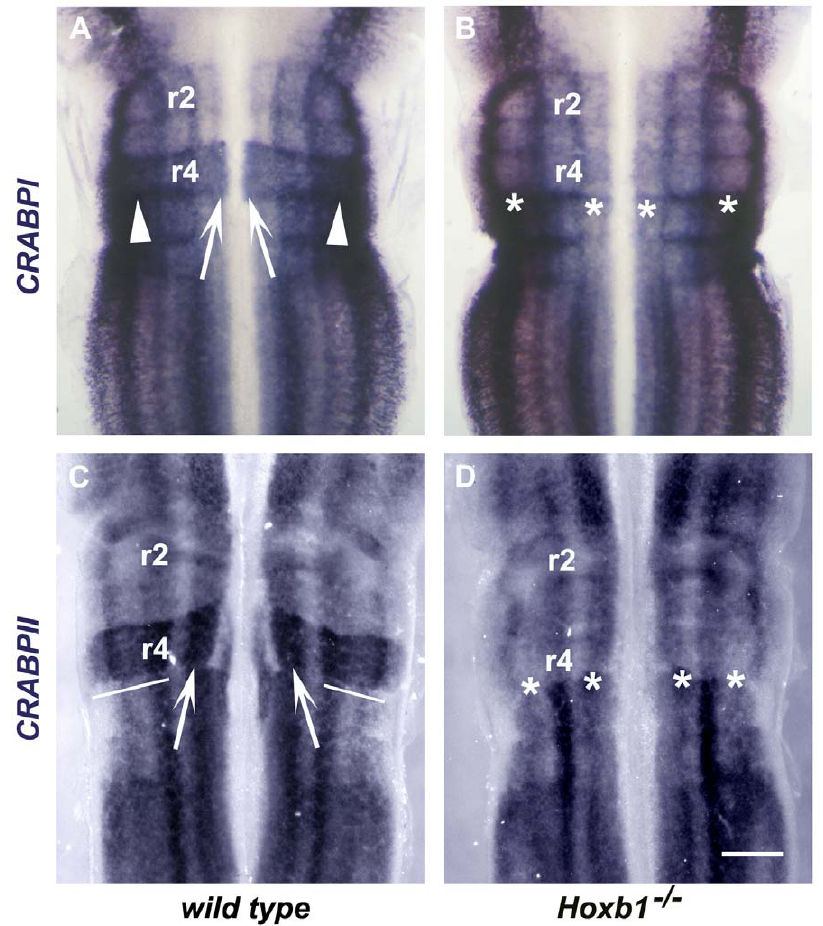
Figure 3. Expression of CRABPI and CRABPII in the hindbrain of wt and Hoxb1 2 / 2 mouse embryos at 10.5 dpc. (A – D) Ventricular views of flat mounted wt (A, C) and Hoxb1 2 / 2 (B, D) mouse hindbrains stained with a CRABPI riboprobe (A, B) and a CRABPII riboprobe (C, D) at 10.5 dpc. r4-specific expression is denoted by arrows (A, C), arrowheads (A) and brackets (C) in wt hindbrains. r4-specific expression is lost in Hoxb1 2 / 2 hindbrains and denoted by asterisks (B, D). Scale bar corresponds to 450 m